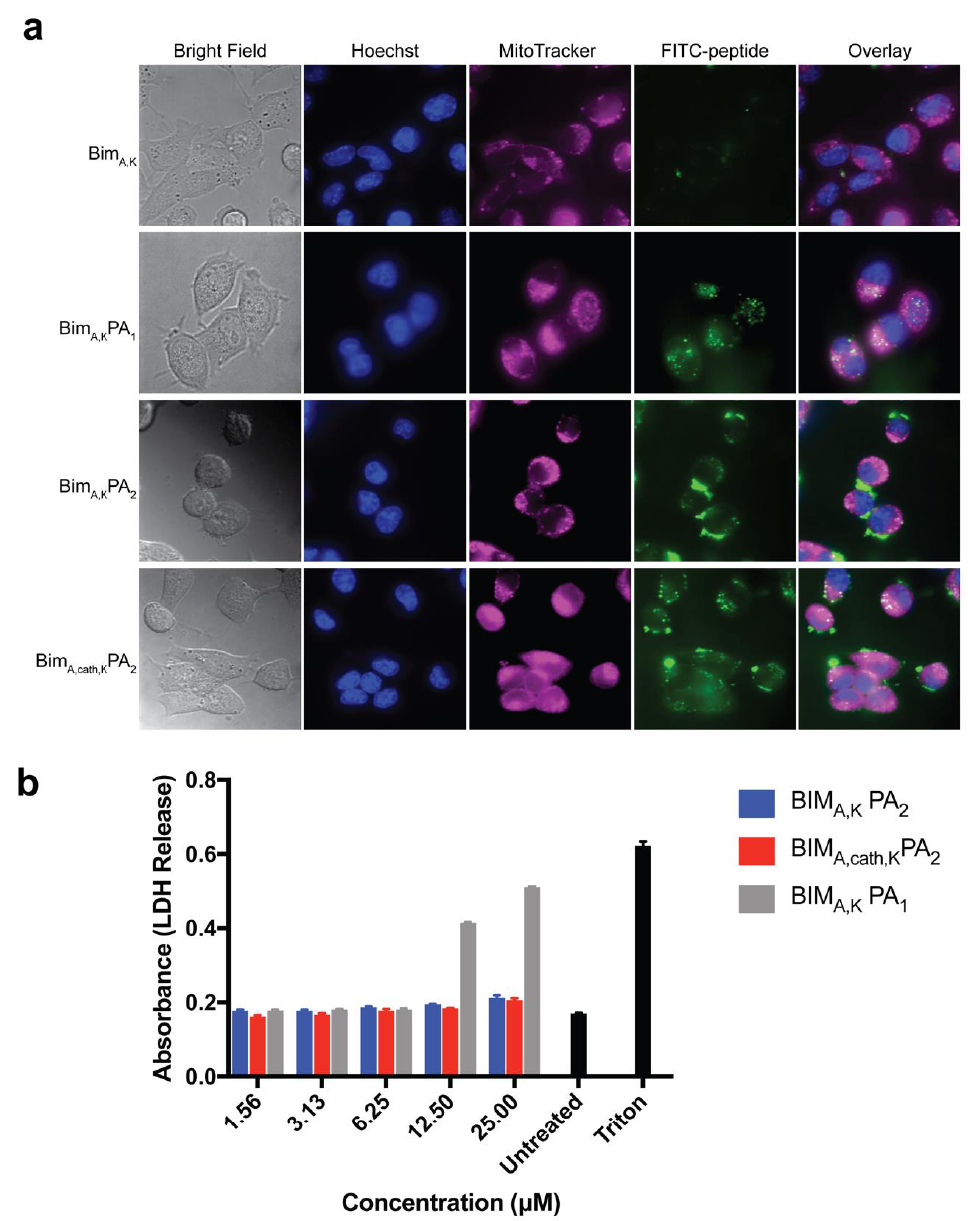
Figure 2. Addition of lipid tails imparts cell uptake to an otherwise cell-impermeable BIM BH3 peptide. ( a ) Live cell confocal microscopy of HeLa cells treated with fluorescein isothiocyanate (FITC)-labeled BIM A,K peptide , BIM A,K PA 1 , BIM A,K PA 2 , or BIM A,cath,K PA 2 for 2 h followed by washing. BIM A,K PA 1 and BIM A,cath,K PA 2 resulted in diffuse intracellular localization of the BIM BH3 peptide. ( b ) BIM A,K PA 1 caused non-specific membrane disruption and LDH release in a dose-dependent manner while BIM A,K PA 2 and BIM A,cath,K PA 2 did not. Values plotted are the mean ± S.E.M.